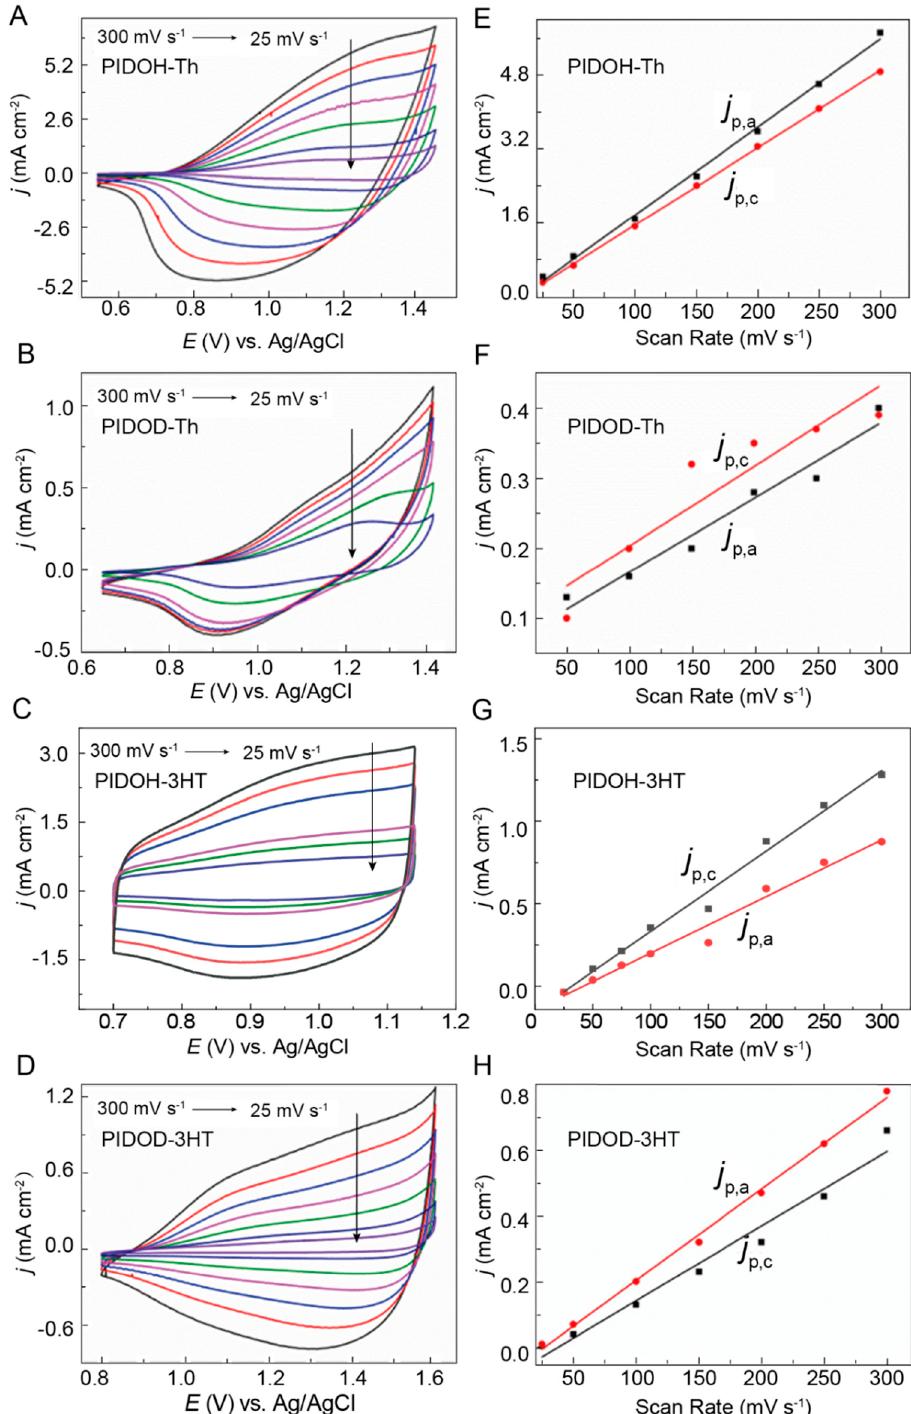
Figure 4. Cyclic voltammograms of ( A ) PIDOH–Th, ( B ) PIDOD–Th, ( C ) PIDOH–3HT, and ( D ) PIDOD–3HT film–modified Pt electrodes at varying scan rates. The scan rates are 300 mV s − 1 , 250 mV s − 1 , 200 mV s − 1 , 150 mV s − 1 , 100 mV s − 1 , 50 mV s − 1 , 25 mV s − 1 , respectively. Corresponding linearity of current density versus scan rate of the doping process for ( E ) PIDOH–Th, ( F ) PIDOD–Th, ( G ) PIDOH–3HT, and ( H ) PIDOD–3HT. j p,a (dots) and j p,c (square) denote the anodic and cathodic peak current densities,